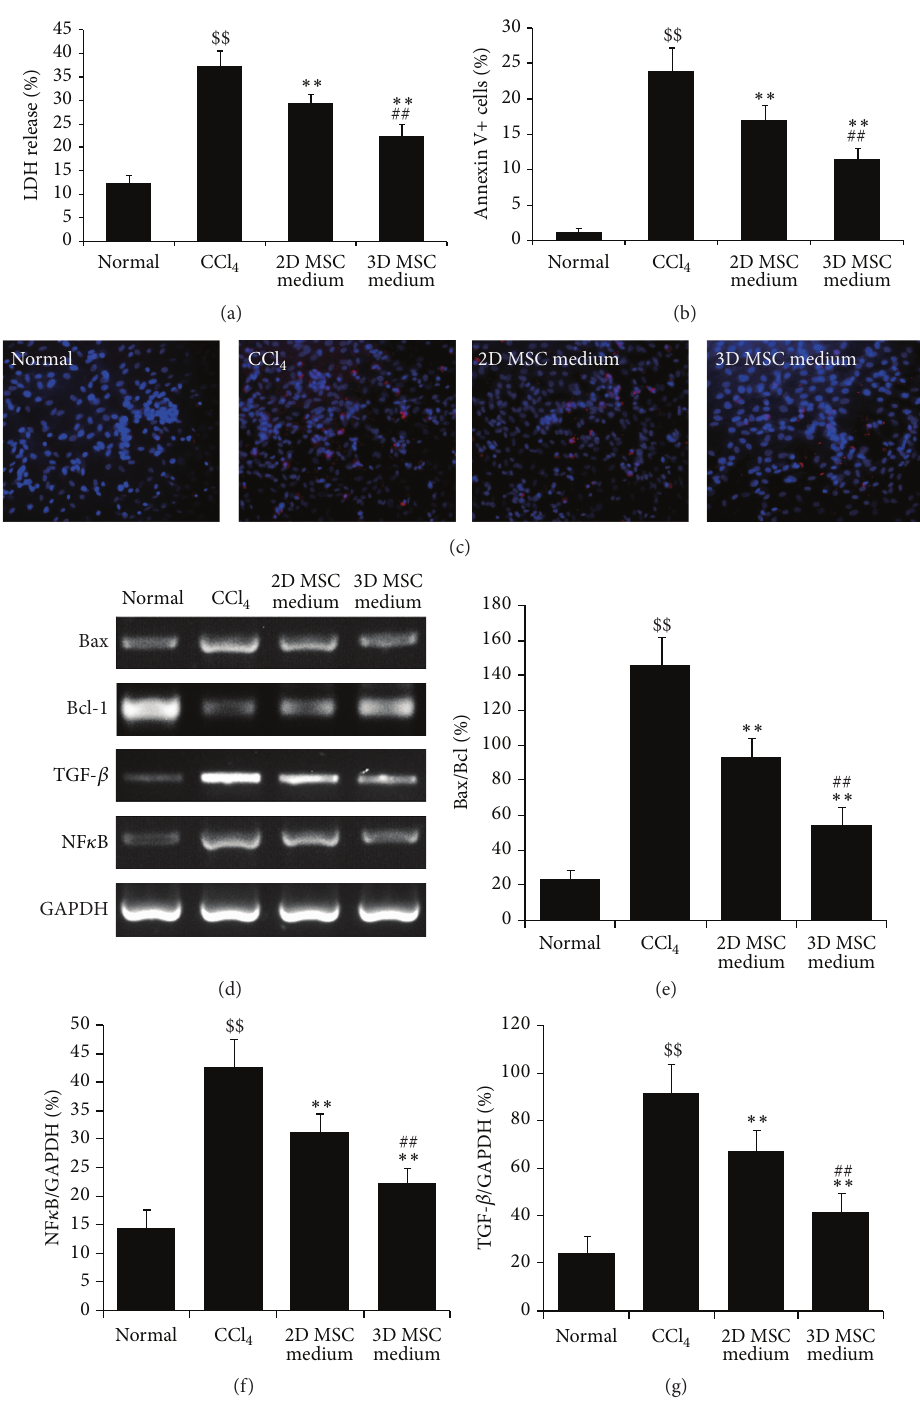
Figure 2: Protection of 3D spheroid-derived MSCs on hepatocyte injury in vitro . Hepatocytes were isolated from C57BL/6 mice and cultured in collagen-coated 6-well plates. After treatment with CCl 4 for 6h, the medium of cells was replaced with normal medium, conditioned medium of 2D cultured MSCs, or conditioned medium of 3D spheroids of MSCs for 24 h before LDH assays, apoptosis analysis, and RT- PCR. (a) LDH assays. (b) Statistics of Annexin V staining. (c) Images of Annexin V staining. Annexin V staining was performed to evaluate cell apoptosis (red), with DPAI for nucleus staining (blue). (d) RT-PCR. The mRNA levels of Bax, Bcl-1, NF 𝜅 B, and TGF- 𝛽 were tested by RT- PCR, with GAPDH as the internal control. (e) Quantitative analysis of Bax/Bcl mRNA level. (f) Quantitative analysis of NF 𝜅 B mRNA level. Band intensities of NF 𝜅 B were normalized to those of the internal control. (g) Quantitative analysis of TGF- 𝛽 mRNA level. Band intensities of TGF- 𝛽 were normalized to those of the internal control. $$ 𝑝 < 0.01 compared with normal; ∗∗ 𝑝 < 0.01 compared with CCl 4 ; ## 𝑝 < 0.01 compared with 2D MSC